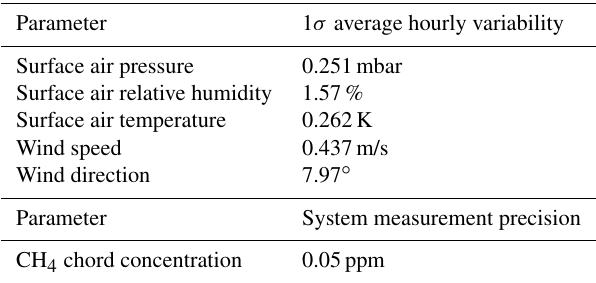
Table 1. Meteorological parameter variances and system measure- ment precision used in Monte Carlo simulation.